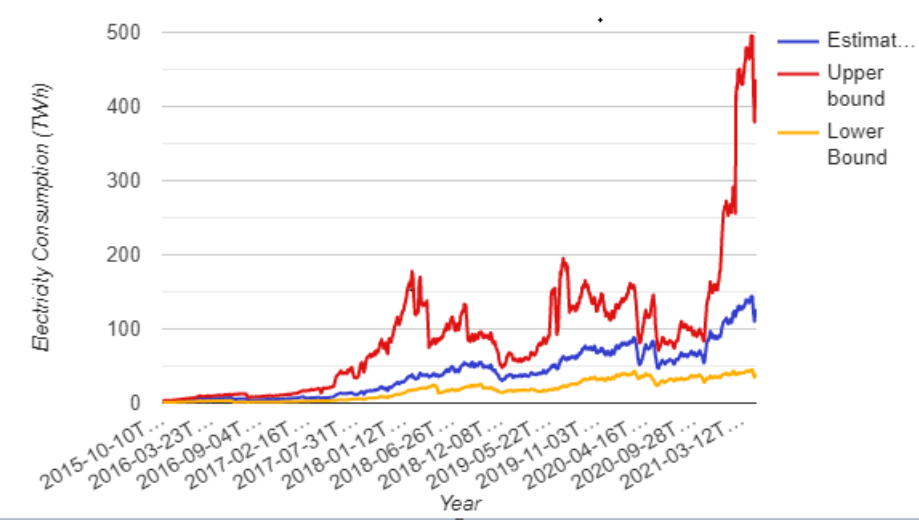
Figure 3. Annual Bitcoin energy consumption (TWh) [9].